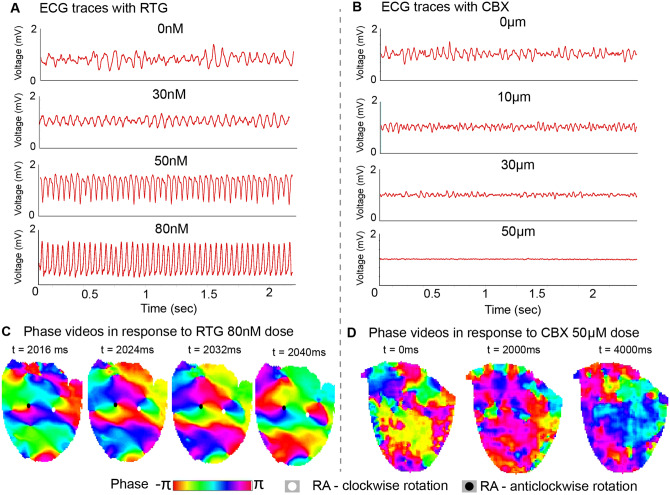
Enhanced GJ coupling regularizes VF to VT. Representative ECGs in response to (A) RTG (0–80 nM) with progressive regularization of VF to VT and (B) CBX (0–50 µM) with progressive VF disorganization on ECG. (C) Representative phase maps with tracked RAs in VF in response to RTG 80 nM showing existence of spatially stable RAs. (D) Representative phase maps in VF in response to CBX 50 µM showing disorganized myocardial activation only.